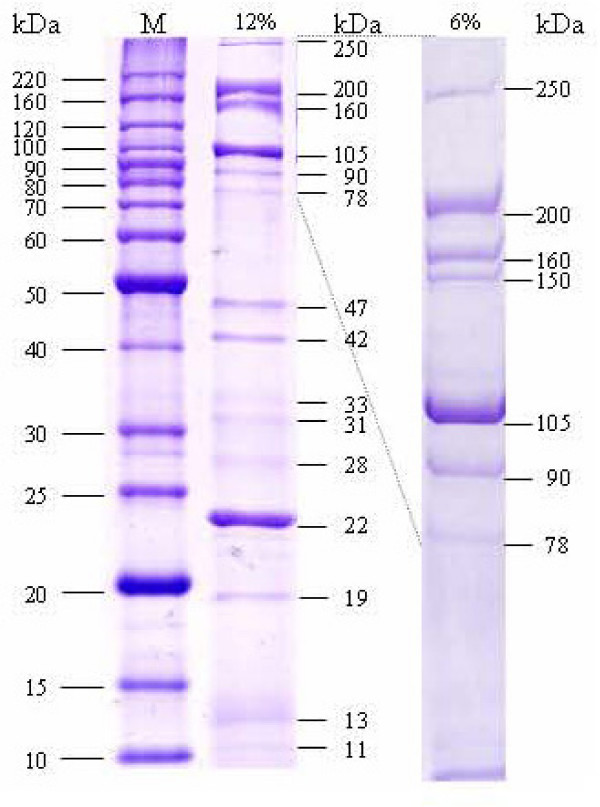
SDS-polyacrylamide gel electrophoresis of Xop411 virion proteins. The purified Xop411 particles were separated in 12% (middle lane) or 6% (right lane) polyacrylamide gels and stained with Coomassie brilliant blue. The proteins are named by their apparent sizes. Lane M contained molecular weight markers.